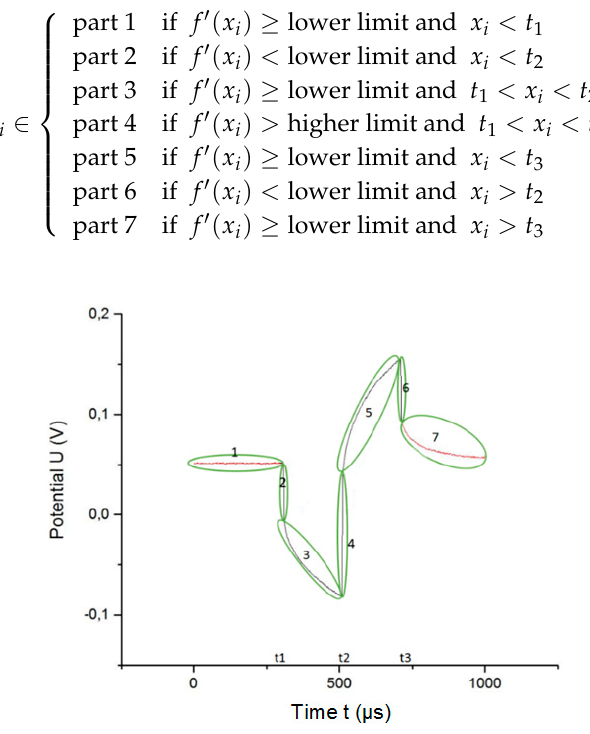
Figure 8. The voltage transient is divided into seven parts to graphically correct the access voltage.